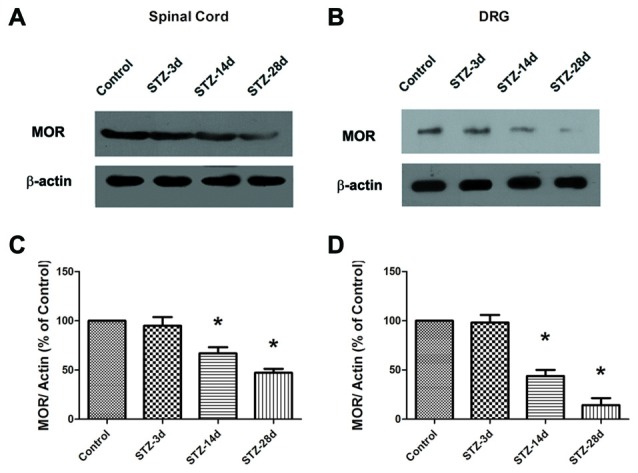
The expression of MOR was detected in the spinal cord (A) and the dorsal root ganglion (DRG; B) by Western blotting. Statistical analysis of MOR in the spinal cord (C) and the DRG (D) in different groups. The sample of the control group was set at 100%. Mean ± SD, n = 6 per group. *p < 0.05 vs. non-diabetic control rats.